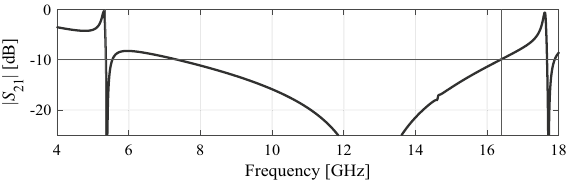
Figure 6. Definition of the FSS unit cell bandstop: f L and f H denote the lower and upper ends of the bandstop, whereas S max stands for the maximum transmission level within the operating bandwidth.